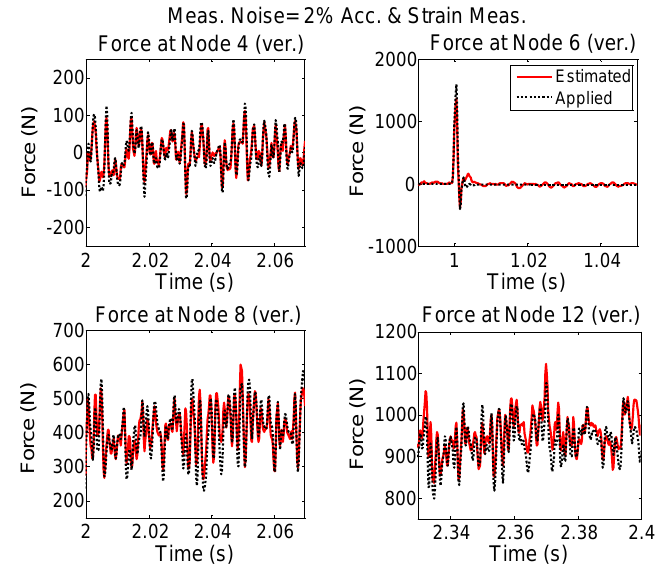
Figure 17. The results shown in Figure 16 are re-plotted for shorter time intervals to see how the estimation follows the applied forces in more detail.